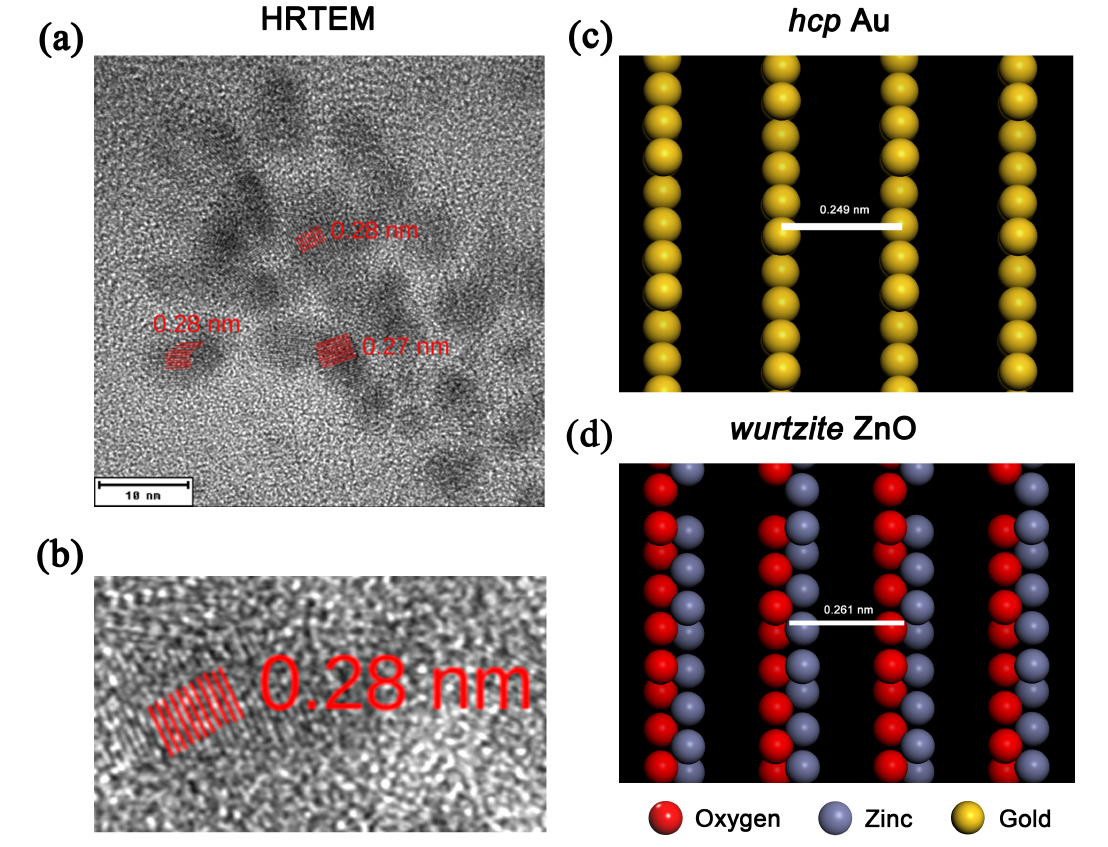
Figure 8. ( a , b ) Interplanar distances shown on HRTEM images and ( c , d ) model of hcp Au (the uncertainty of the evaluation of interplanar distances is around ± 0.03 nm). The models in ( c , d ) were created using Accelrys Materials